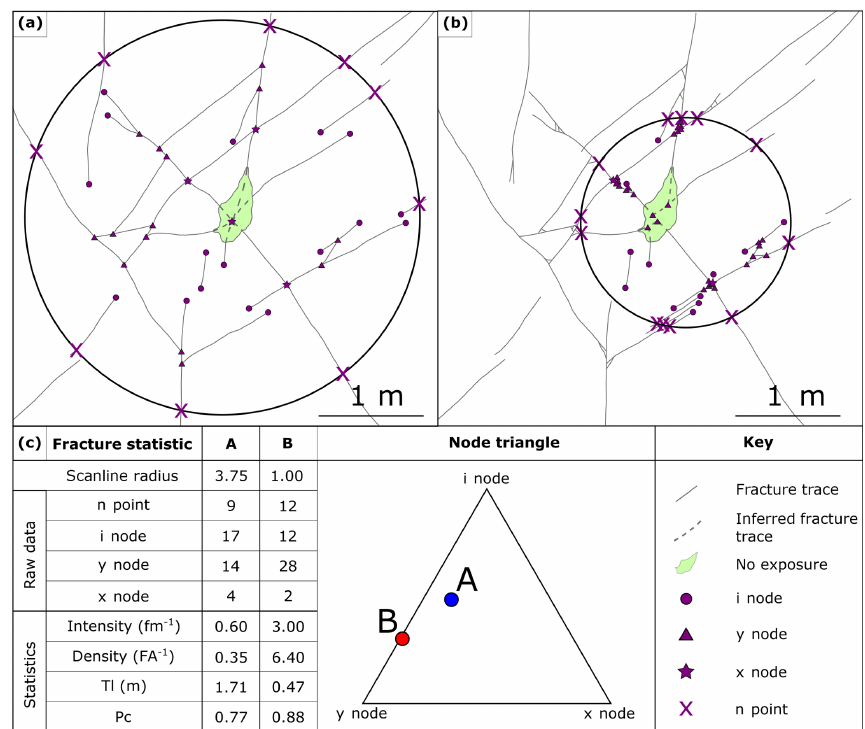
Figure 11. The impact of interpreter style on fracture statistics of a synthetic fracture network. (a) Statistically valid topological sampling within a circular scanline for a fracture network which only considers the large-scale fracture network. (b) Statistically valid topological sampling within a circular scanline for the same large-scale fracture network as (a) but also capturing small-scale fractures at fracture intersections. (c) The topology attributes ( n , i , y , and x nodes), derived fracture statistics, and node triangle of the different interpretations of the fracture